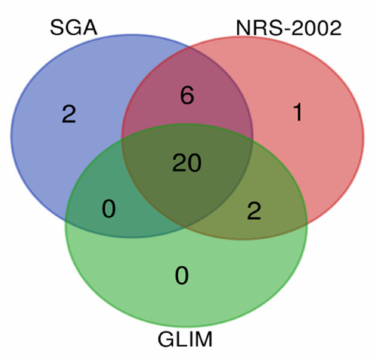
Figure 2. Venn diagram about the number of participants with malnutrition status according to the different nutritional status assessment